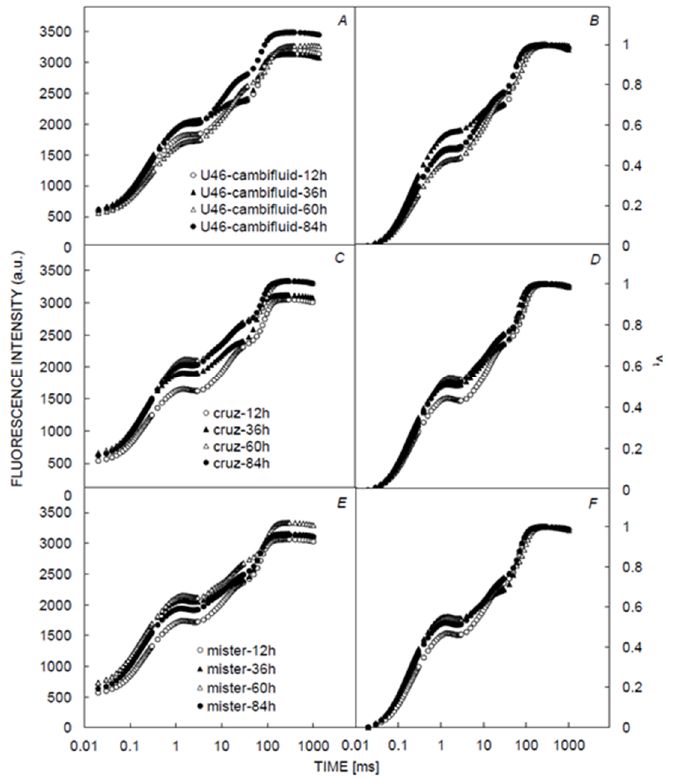
Figure 2. Effect of herbicides on chlorophyll a fluorescence. Effects of different herbicides on the OJIP curve are shown as fluorescence intensity ( A , C , E ) and relative variable fluorescence ( B , D , F ).